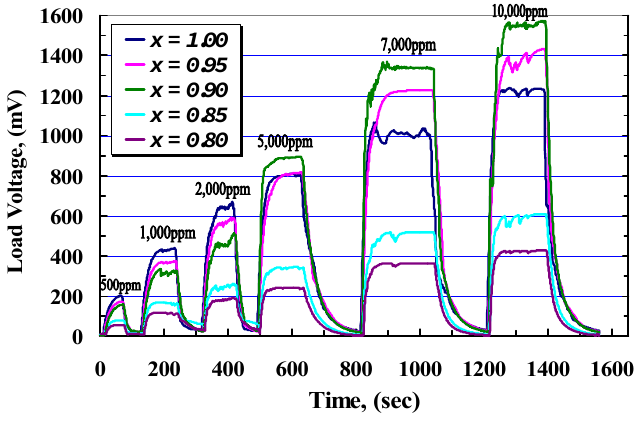
Figure 12. Response of samples to 0.05%, 0.1%, 0.2%, 0.5%, 0.7%, and 1% CH measured at operating temperatures of 405 °C ( x = 1), 395 °C ( x = 0.95), 380 °C ( x = 0.90), 440 °C ( x = 0.85), and 450 °C ( x =